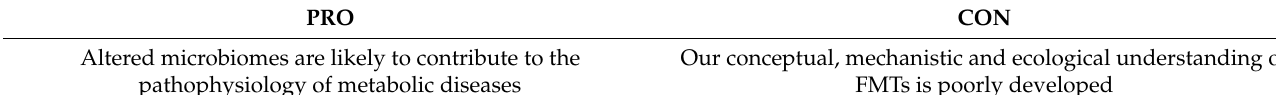
Table 2. Pro and con arguments for/against FMT to treat metabolic